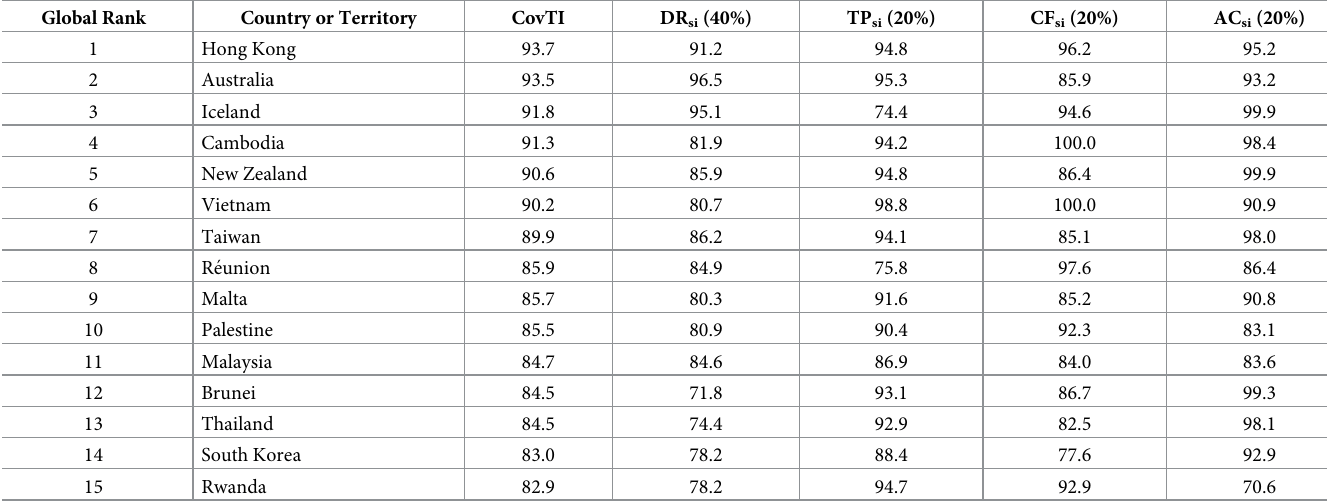
Table 3. COVID-19 Testing Index (CovTI) and sub-indices a) among top 15 countries and territories assessed (n = 165). Global Rank